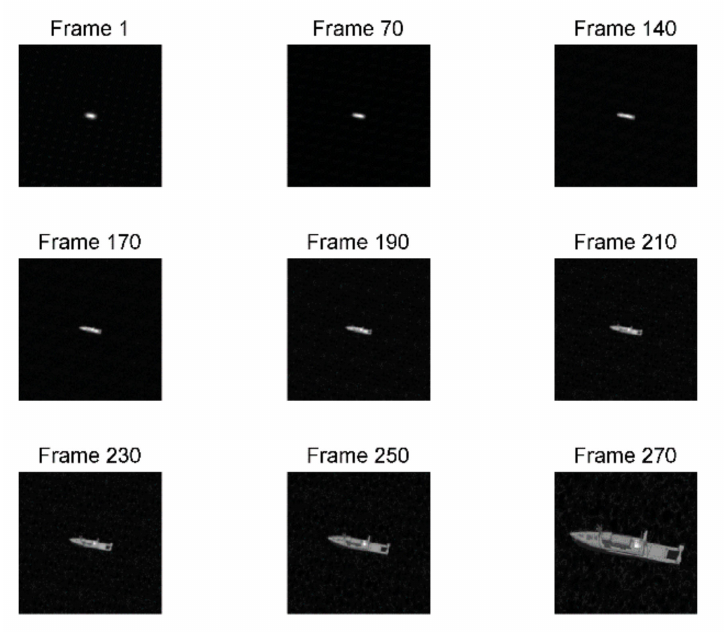
Figure 11. A sequence of IR aerodynamic degradation